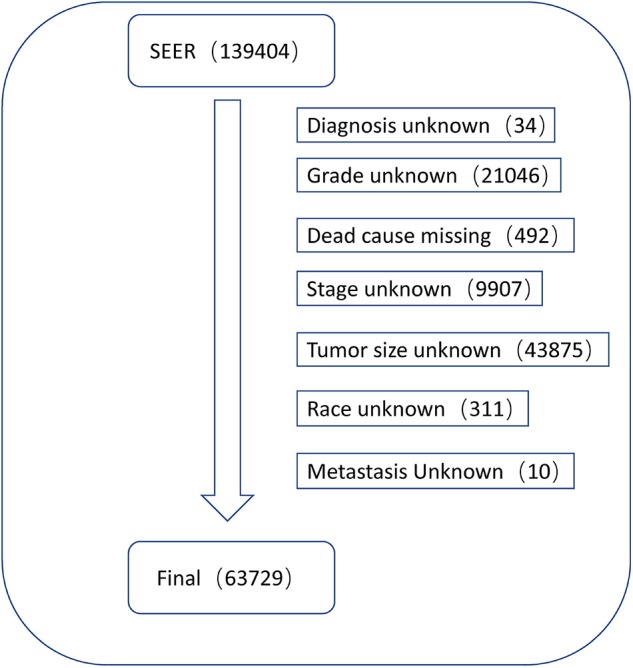
The flow chart of data process.